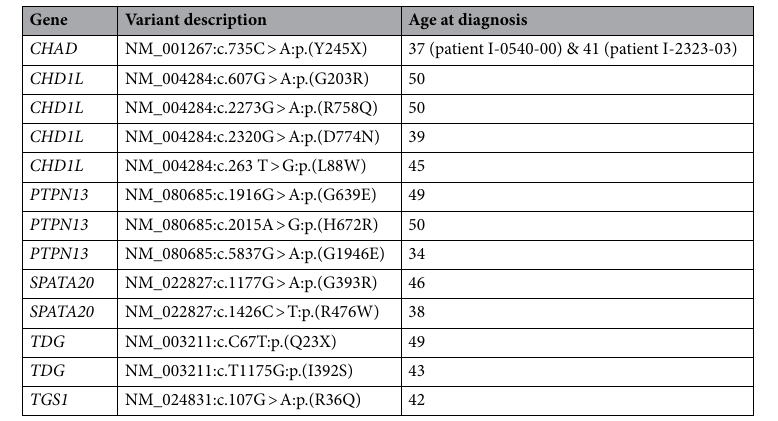
Table 2. Variants found in the eight candidate genes in the replication cohort. Thirteen rare, high-impact variants were found in six of the eight genes selected for validation. None of the patients carried more than one variant.